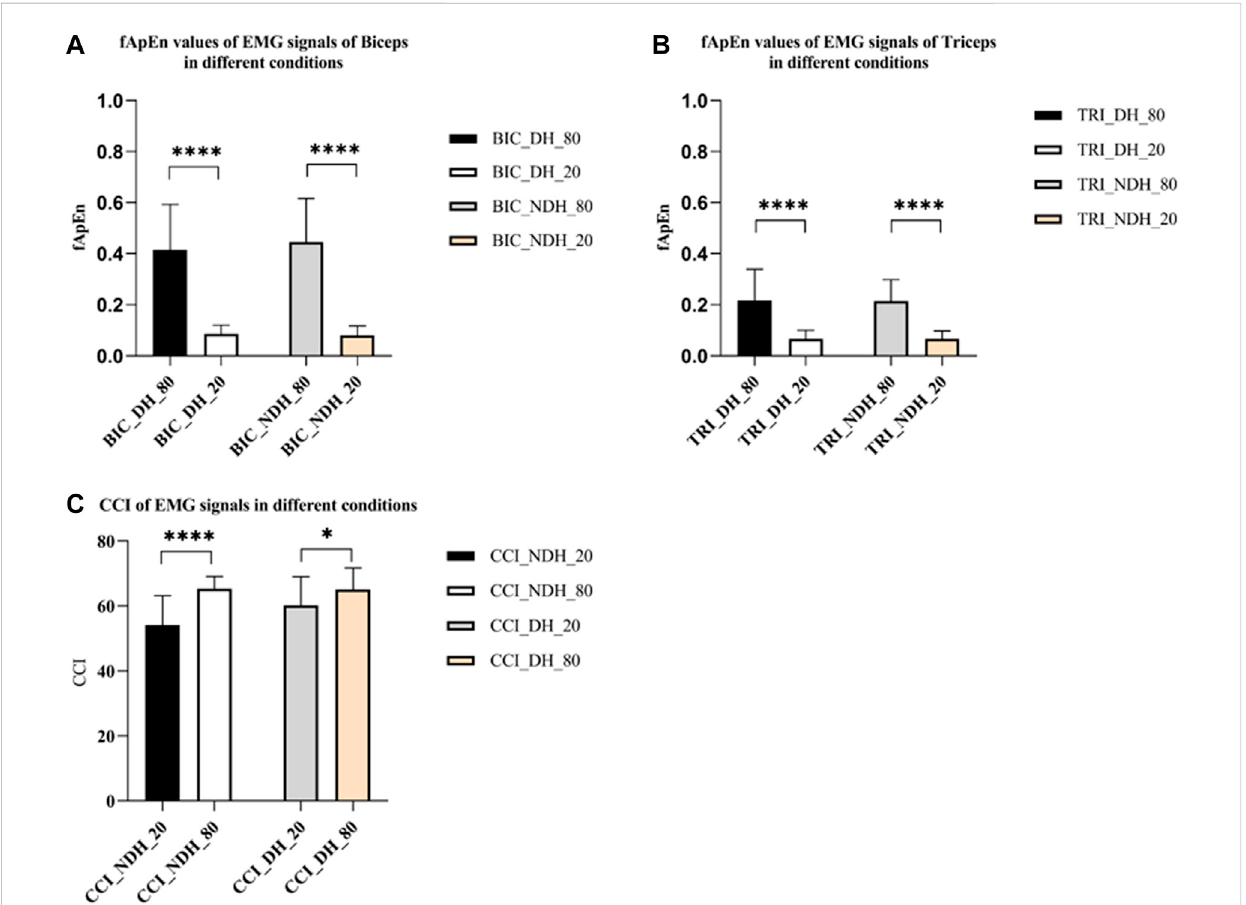
FIGURE 7 (A) fApEn values of EMG signals of BIC. (B) fApEn values of EMG signals of TRI. (C) The CCI of EMG signals in different conditions. The signi fi cant difference between different conditions was represented by * p < 0.05 and **** p < 0.0001. Abbreviation: DS, dominant side; NDS, non-dominant